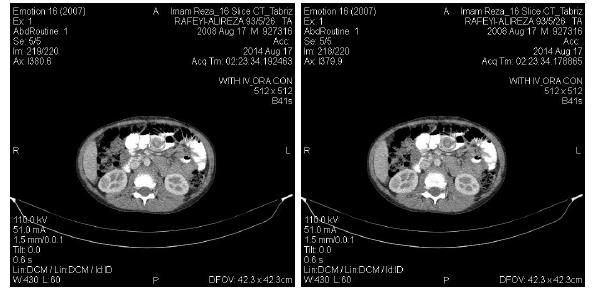
Figure 1. Double contrast abdominal CT